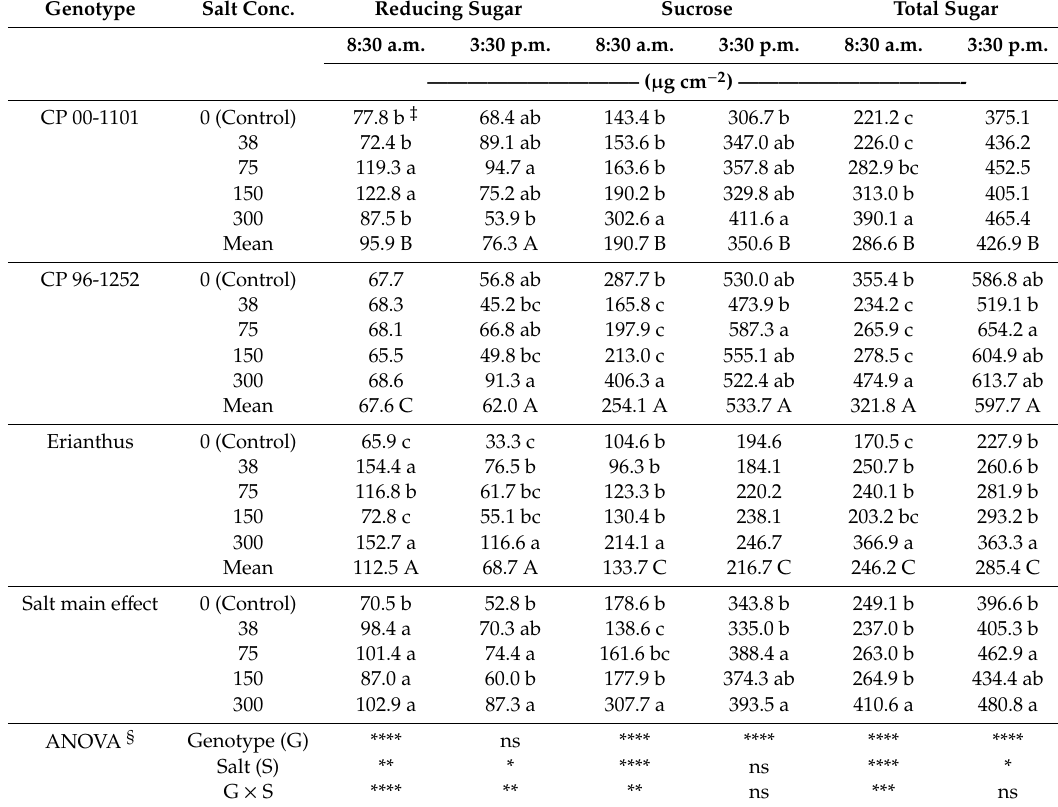
Table 2. Leaf reducing sugar (glucose + fructose), sucrose, and total sugar (reducing sugar + sucrose) concentrations in the early morning (8:30 a.m.) and afternoon (3:30 p.m.) of two sugarcane cultivars (CP 00-1101, CP 96-1252) and an Erianthus as a ff ected by salt (NaCl) concentration (mM) with analysis of variance (ANOVA) of genotype and salt main e ff ects and their interactions † . Genotype Salt Conc. Reducing Sugar Sucrose Total Sugar 8:30 a.m. ——————————– ( µ g cm − 2 )